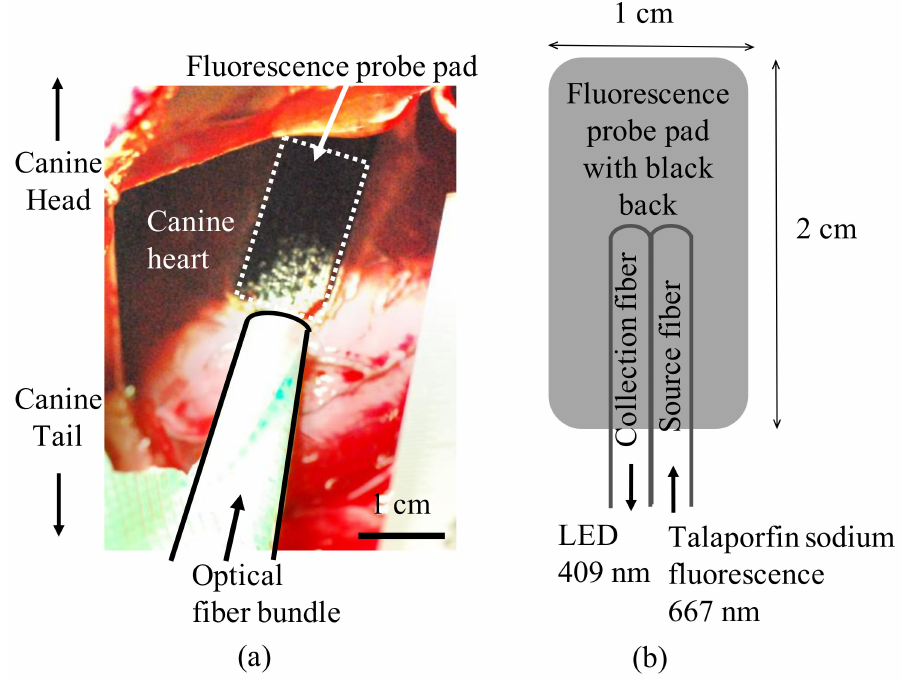
Figure 1. Fluorescence-sensing probe pad installation on an open-chested beagle heart. ( a ) Image